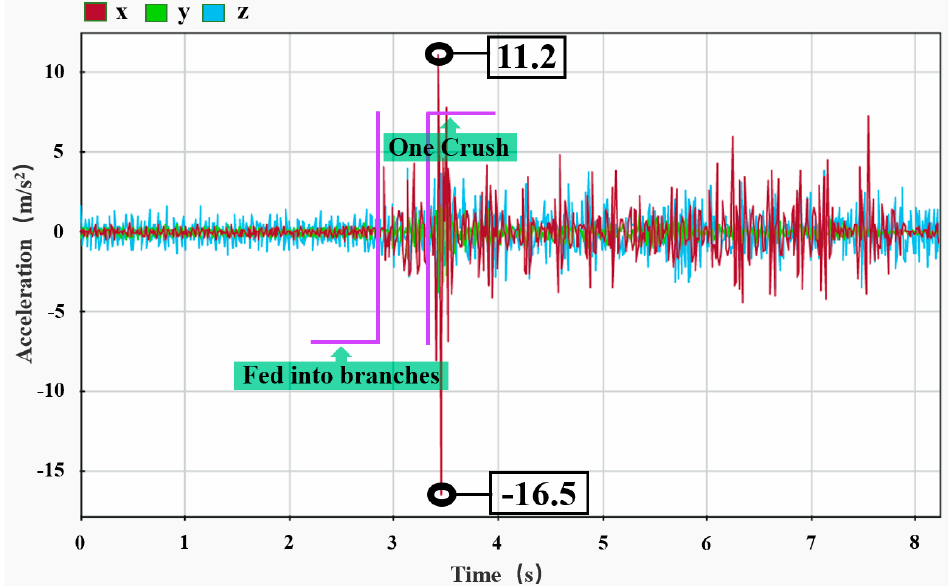
Figure 16. Static crushing test results of the support rod. Figure 16. Static chipping test results of the support